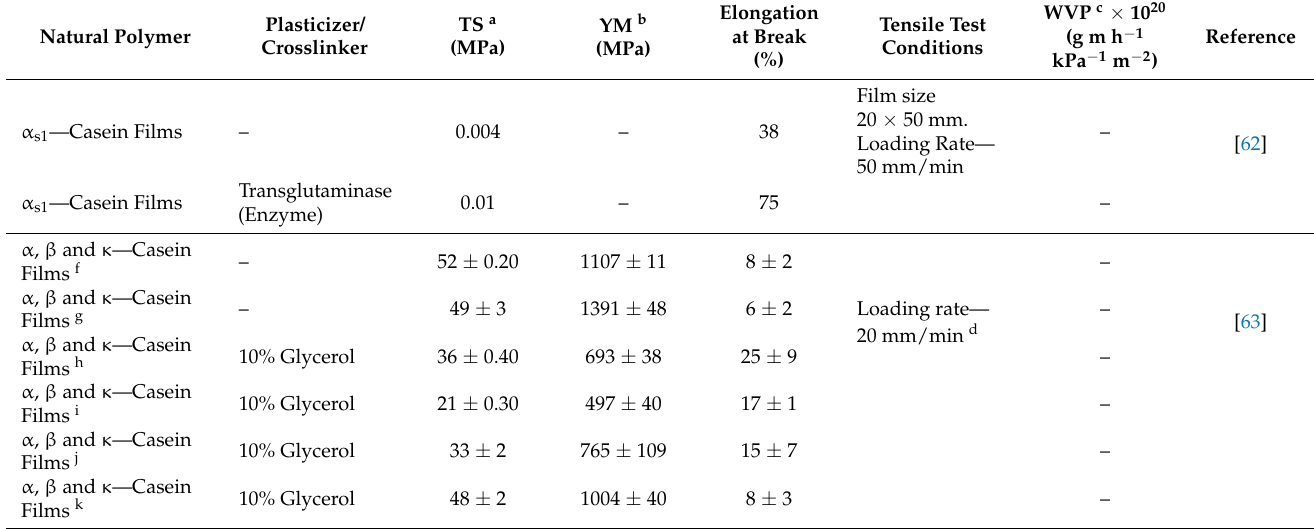
Table 2. Tensile and barrier properties of animal protein